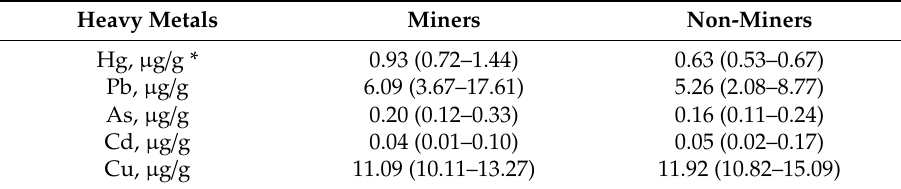
Table 2. Analysis of heavy metals in hair samples.